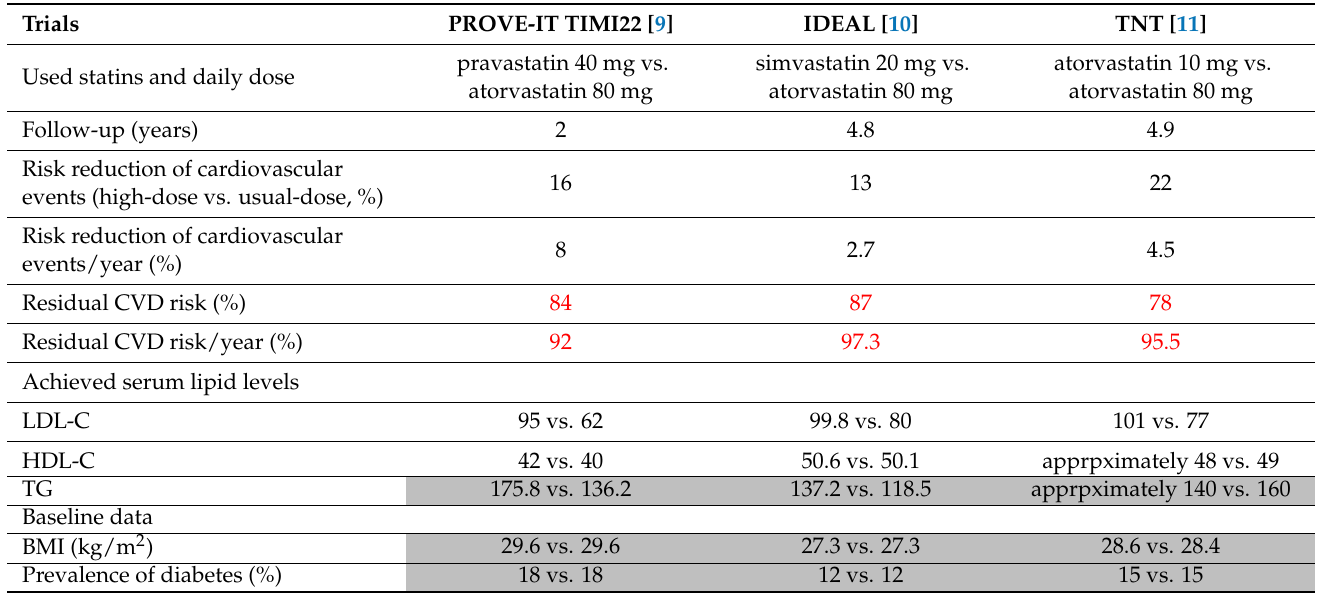
Table 2. R+A1:D11andomized, double blind, placebo-controlled trials to study the effect of high-dose and usual-dose of statins on the development of cardiovascular